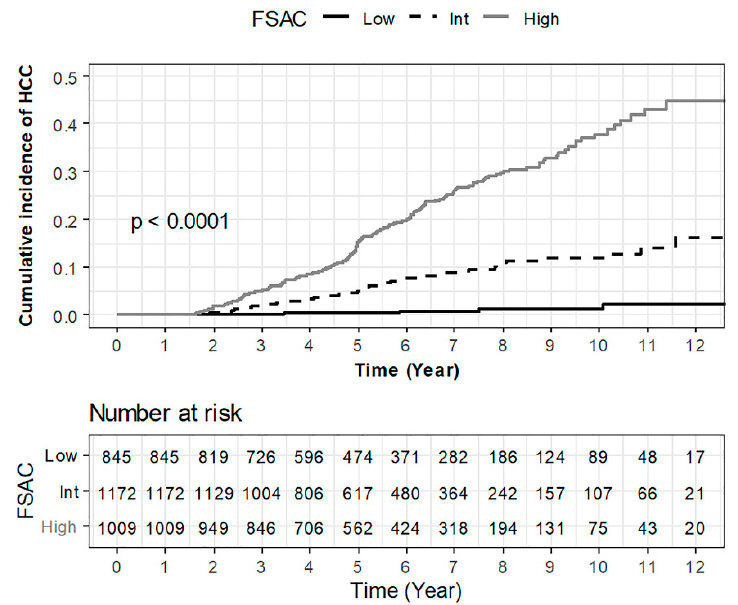
Figure 3. Cumulative probability of HCC development according to risk stratification by the FSAC model among treatment-naïve CHB patients after initiating AVT. HCC, hepatocellular carcinoma; CHB, chronic hepatitis B; AVT, antiviral therapy.